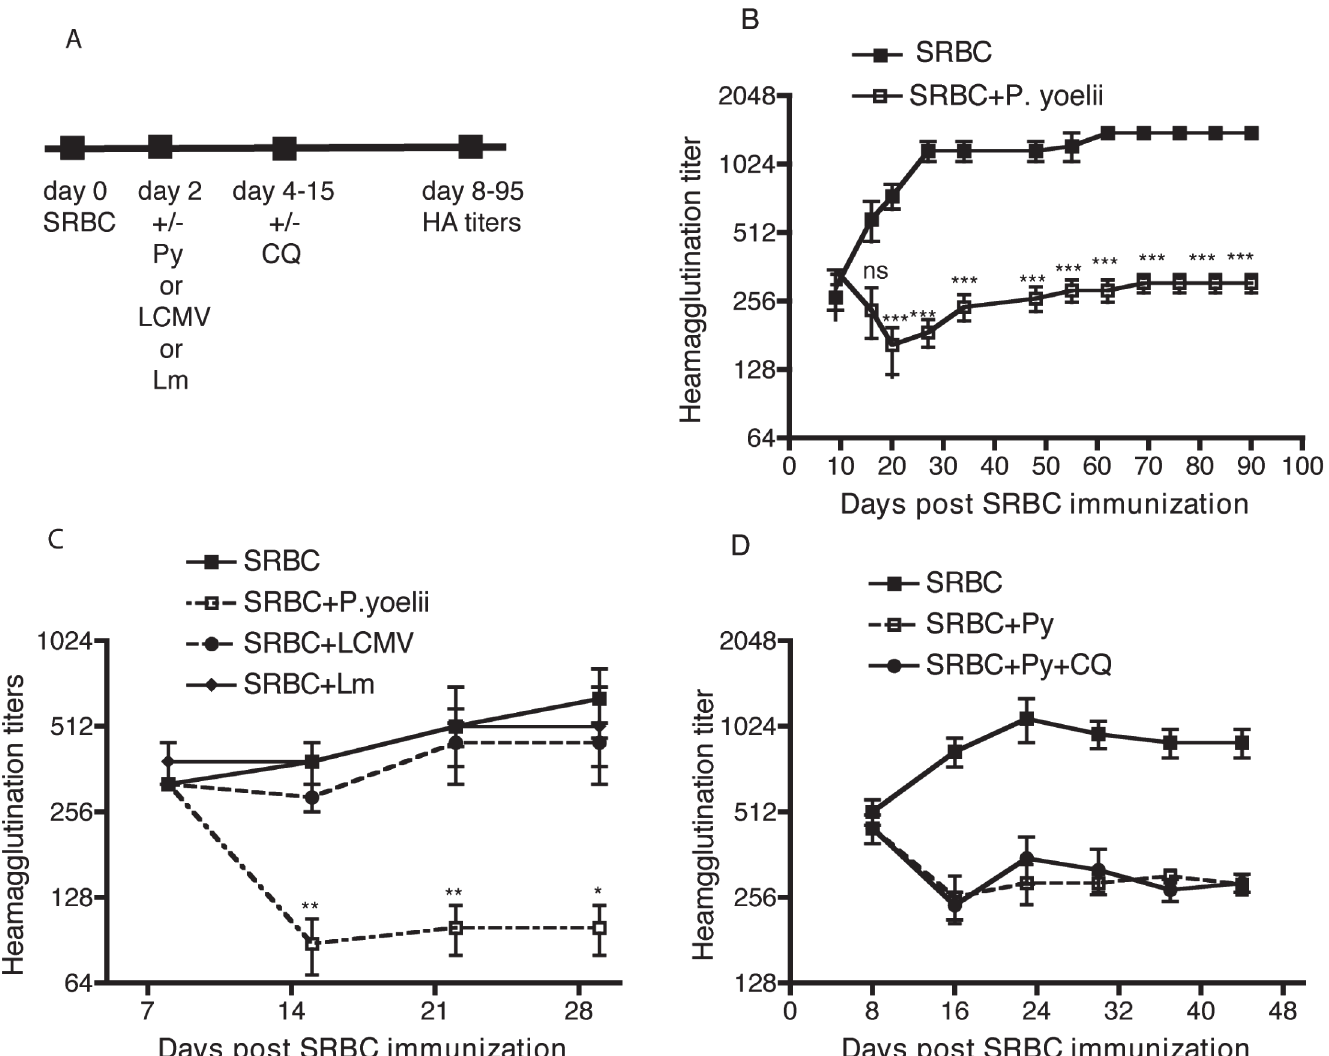
Fig 1. Decrease of SRBC-specific antibody responses after P . yoelii infection. A : Experimental design. Female BALB/c mice were immunized with 10% SRBC suspension intraperitoneally. Two days later, half of these mice were infected with 10 5 P . yoelii infected RBCs intravenously, while the other half of mice were injected with saline. Serum samples were collected on specific days and analyzed for Heamagglutination titers. B : Heamagglutination titers over a period of 90 days in mice immunized with SRBC and infected or not infected with P . yoelii . C : SRBC immunized mice were injected with saline or infected after two days with P . yoelii , L . monocytogenes (5 X 10 6 cfu) or LCMV (2 X 10 5 pfu) and Heamagglutination titers were analyzed over a period of 30 days. D : SRBC immunized mice were injected with saline or infected after two days with P . yoelii . Some P . yoelii infected mice received chloroquine (50 mg per kg) on days 4, 7, 10, 12 and 15 post infection to limit blood stage parasitemia and Heamagglutination titers were analyzed over a period of 30 days. Parasitemia did not exceed 4% in the chloroquine treated mice. The data are representative of two or more independent experiments with10 mice per group/exp. * p < 0.05, ** p < 0.01, *** p <